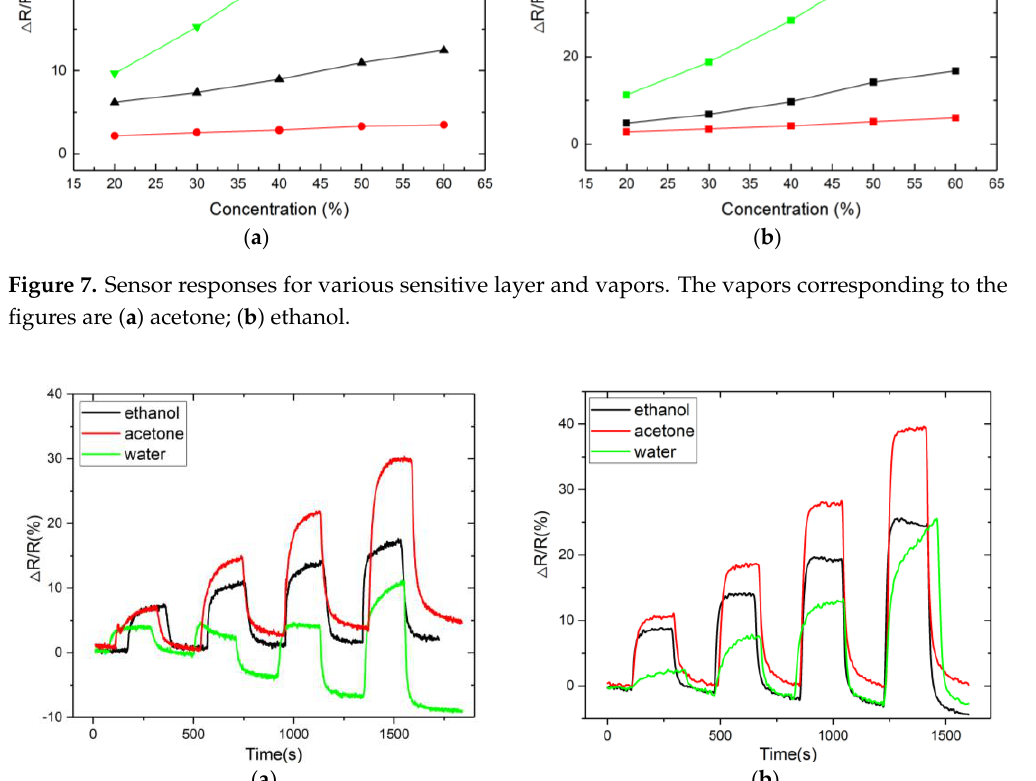
Figure 8. Sensor response comparison of ( a ) MWCNTs and ( b ) PEG/MWCNTs for various VOCs and water vapors.